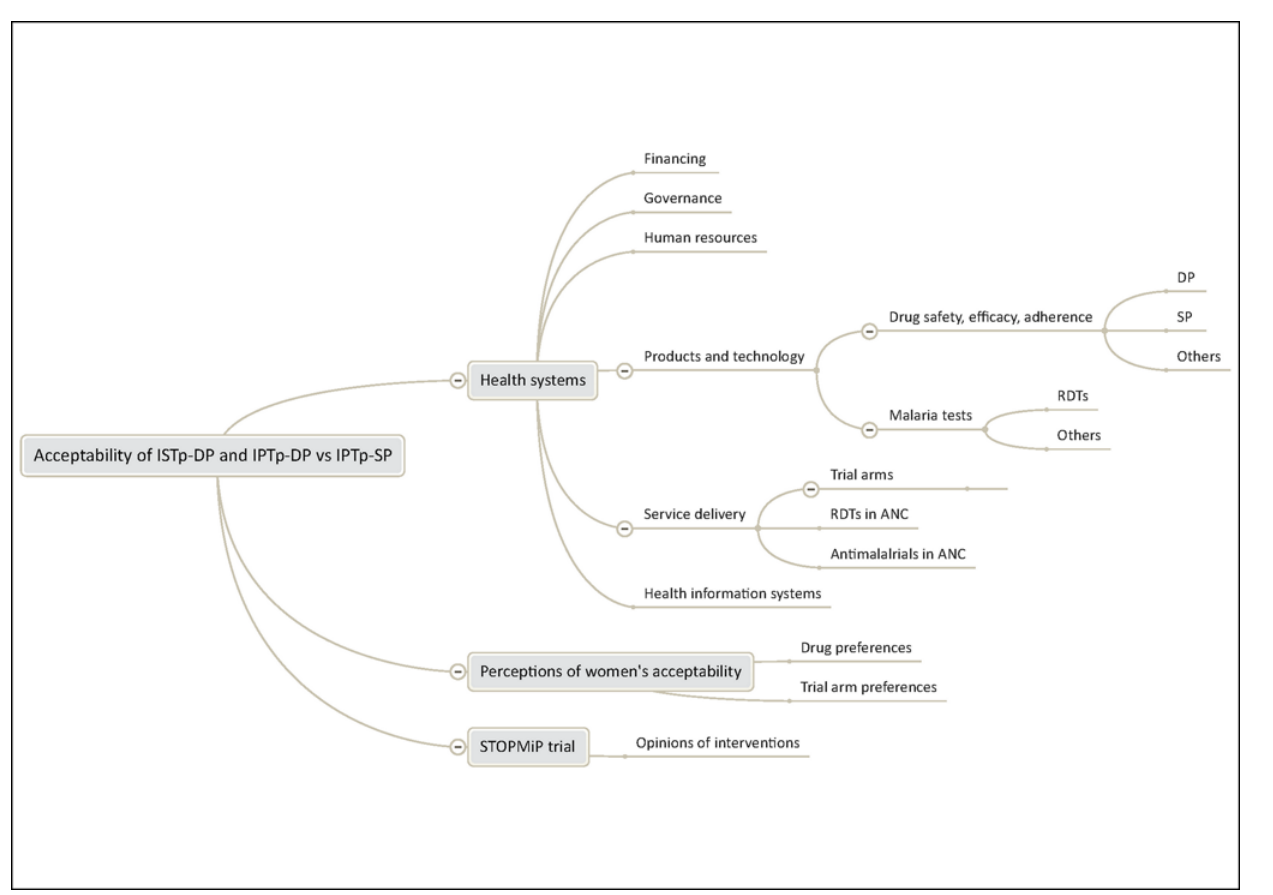
Fig 3. Analysis framework for in-depth interviews with health providers and trial